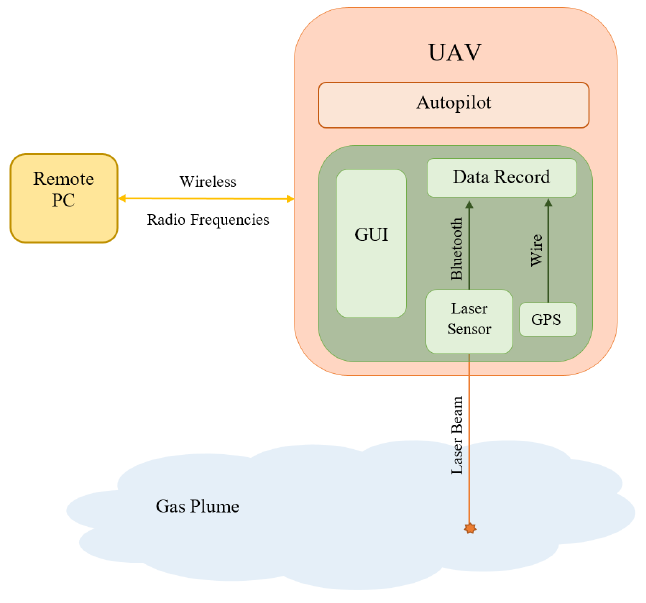
Figure 3. Hardware system